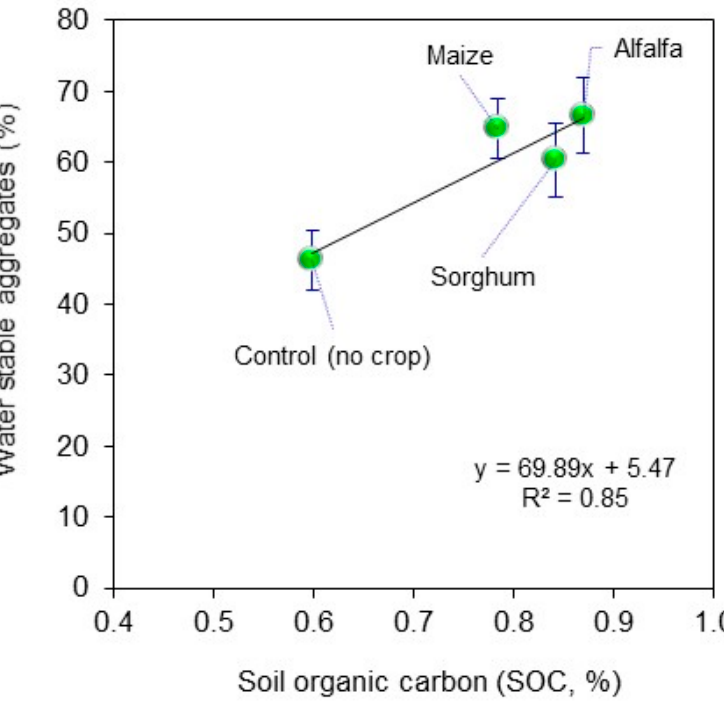
Figure 2. Relation between soil organic carbon (SOC) content and water stable aggregates.